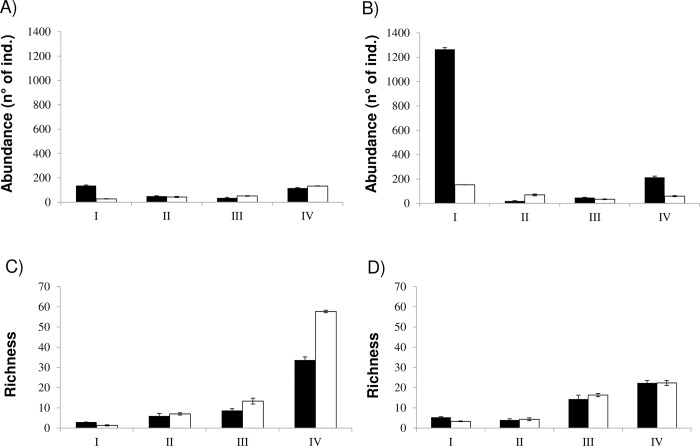
Mean abundance (± standard error) (A; B) and taxon richness (± standard error) (C; D) of benthic macroinvertebrate communities in zones I, II, III and IV of Paraíba do Norte (A; C) and Mamanguape (B; D) estuaries. Black and white bars represent dry wet seasons.